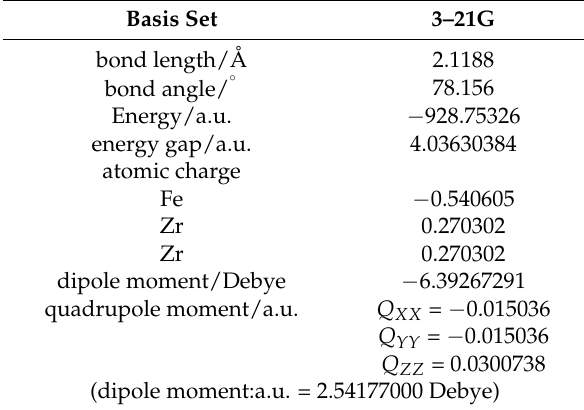
Table 1. Geometry, energy, charge, dipole moment and quadrupole moment of molecular Zr 2 Fe.